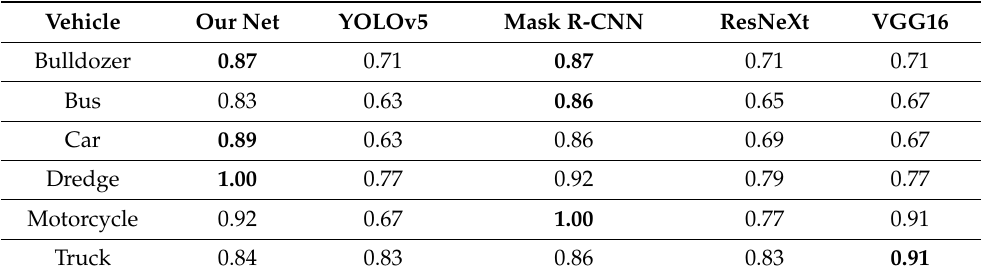
Table 1. Comparison of precision grades for each class. The best indicators for each class are highlighted in bold.